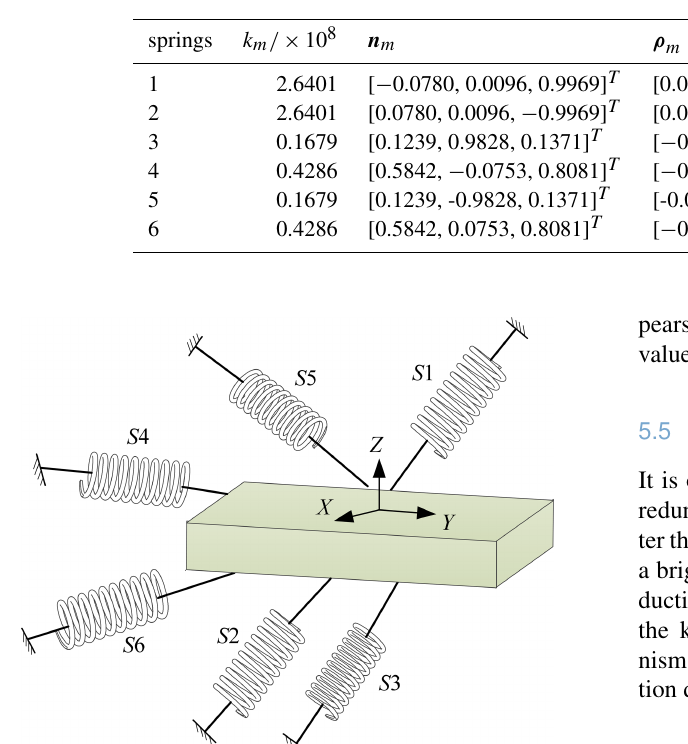
Table 4. Equivalent spring constants.